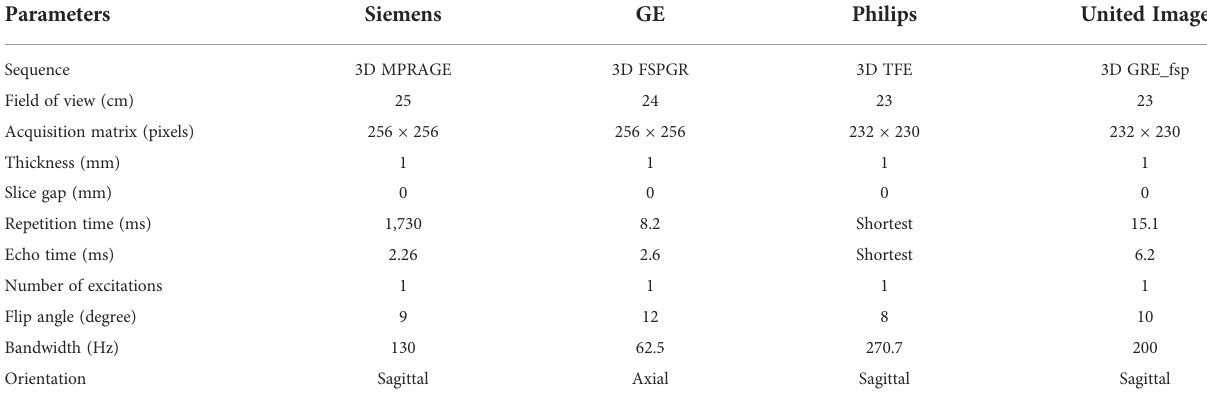
TABLE 1 The critical parameters of CE-MRI protocols.